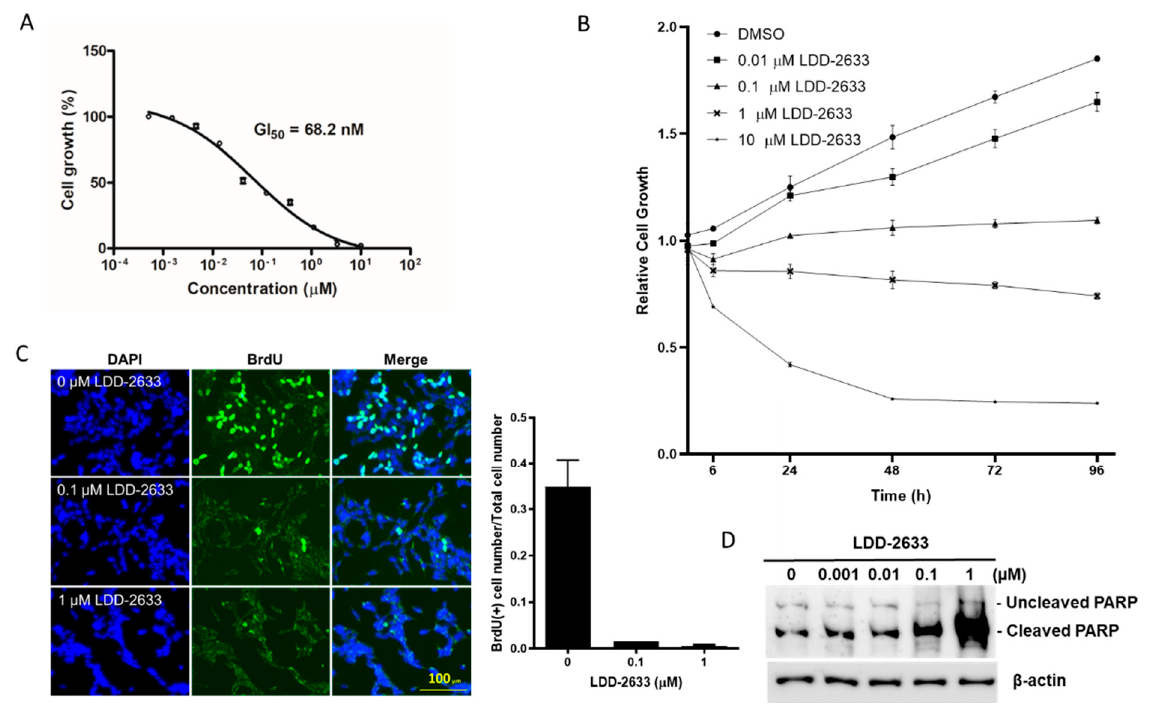
Figure 2. Effect of LDD-2633 on the TT cell growth and apoptosis. ( A ) Cells were treated with LDD-2633 at the indicated concentration for 72 h, and GI 50 was measured using the EZ-Cytox Cell Viability Assay kit. The data are the mean ± SEM of three independent experiments. ( B ) The cell growth curve was determined in the presence of LDD-2633 at the indicated concentration for up to 96 h using EZ-Cytox Cell Viability Assay kit. The data are the mean ± SEM of three independent experiments. ( C ) Cell proliferation was measured using BrdU incorporation assay. Cells were treated with LDD-2633 at the indicated concentration for 24 h and BrdU incorporation was visualized using BrdU immunofluorescence and DAPI staining. The BrdU-containing cells and total cells stained with DAPI were counted and the ratio was used in the graph. ( D ) Cells were treated with LDD-2633 at the indicated concentrations for 48 h and were then subjected to Western blotting analysis using an antibody to detect both cleaved and uncleaved poly (ADP-ribose) polymerase. Immunoblotting analysis of β -actin was presented as the loading control.